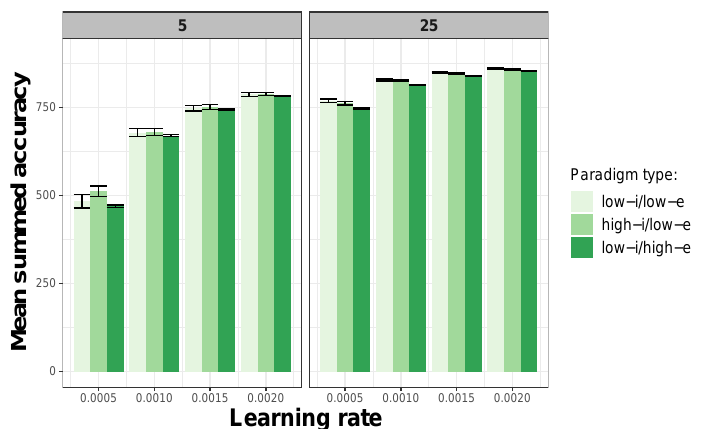
Figure 13: Summed accuracy over the 900 epochs of the networks trained on each of the three paradigm types for models with different learning rates ( x axis) and for models with different dimensions (columns) optimized with